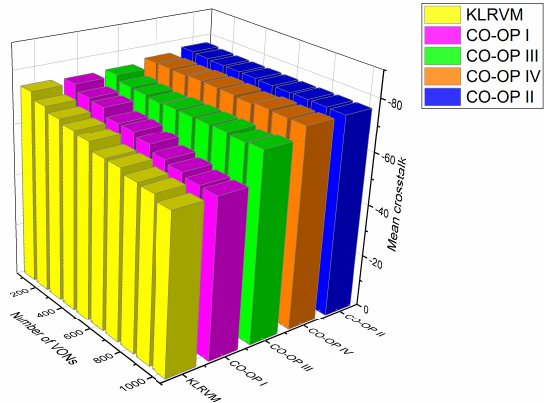
Figure 11. Mean crosstalk for the CHNNET